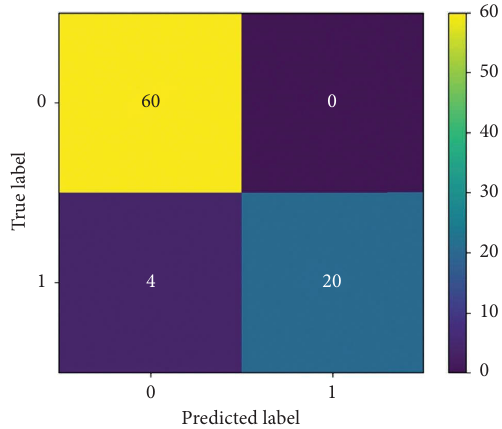
Figure 9: ANN classifcation confusion